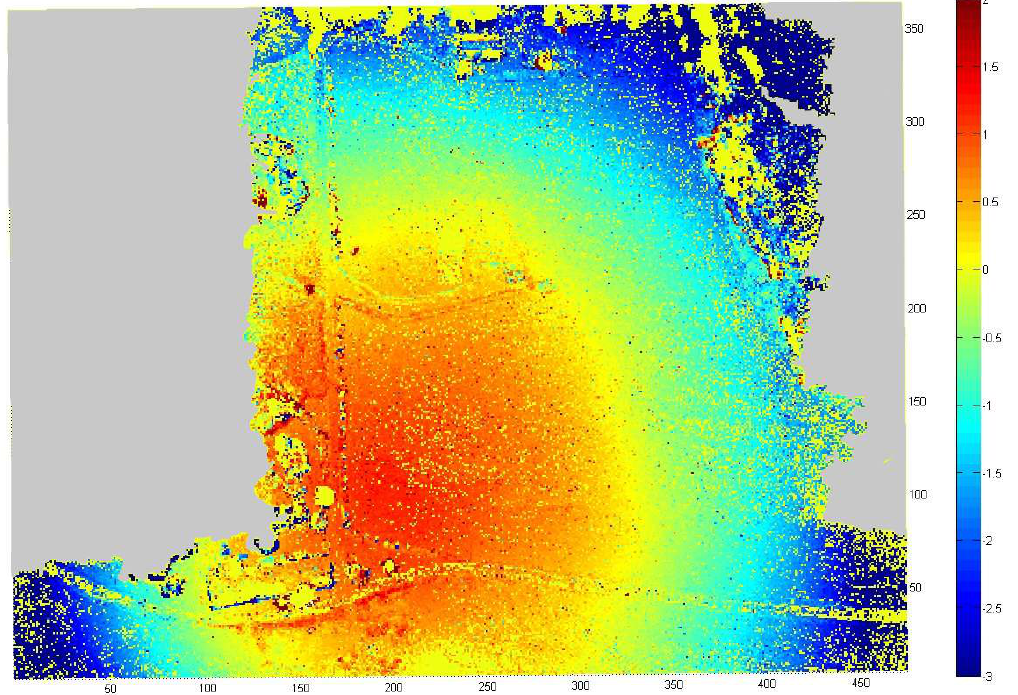
Figure 10. Differences between Photosynth and reference DSMs with 1 m × 1 m point